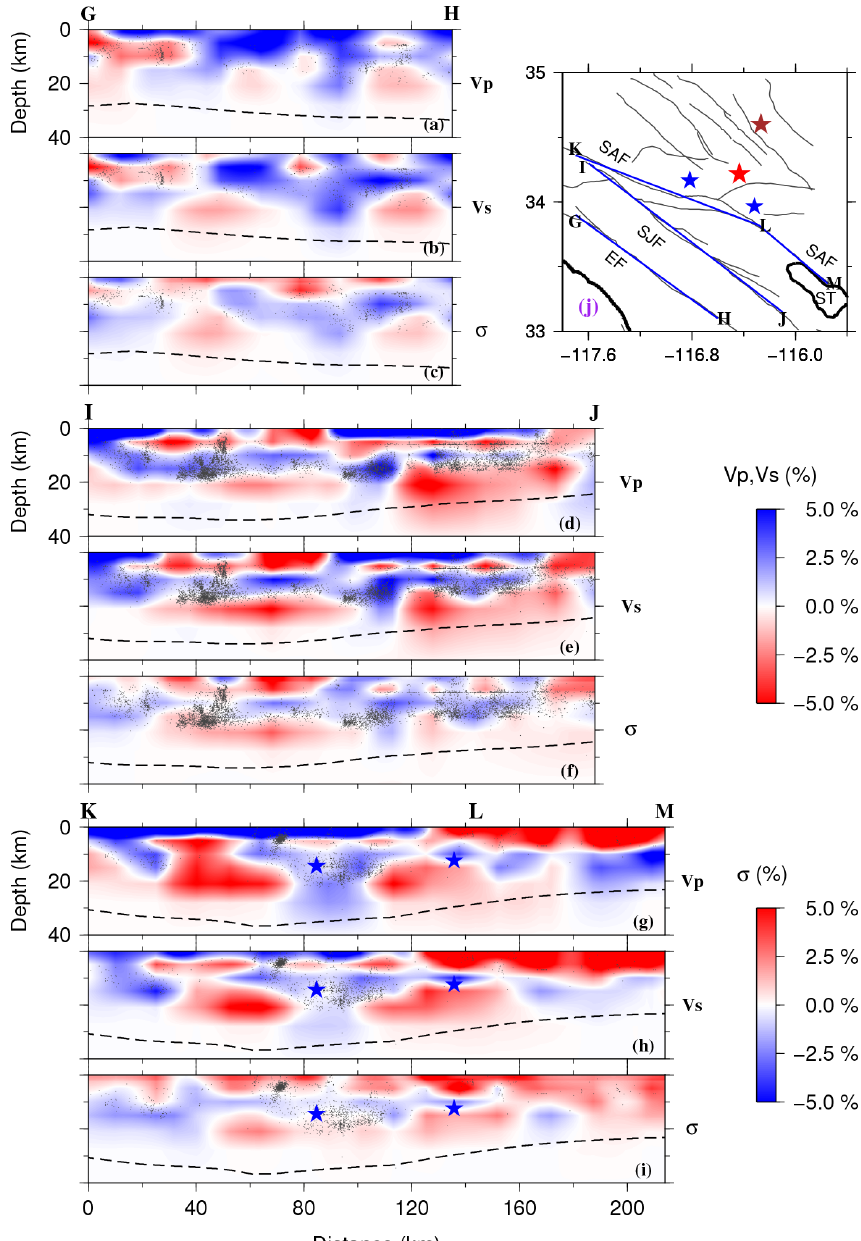
Figure 15. The same as Fig. 14 but along the Elsinore fault (EF), the San Jacinto fault (SJF) and the San Andreas fault (SAF), denoted by cross sections GH (a–c) , IJ (d–f) and KLM (g–i) ,